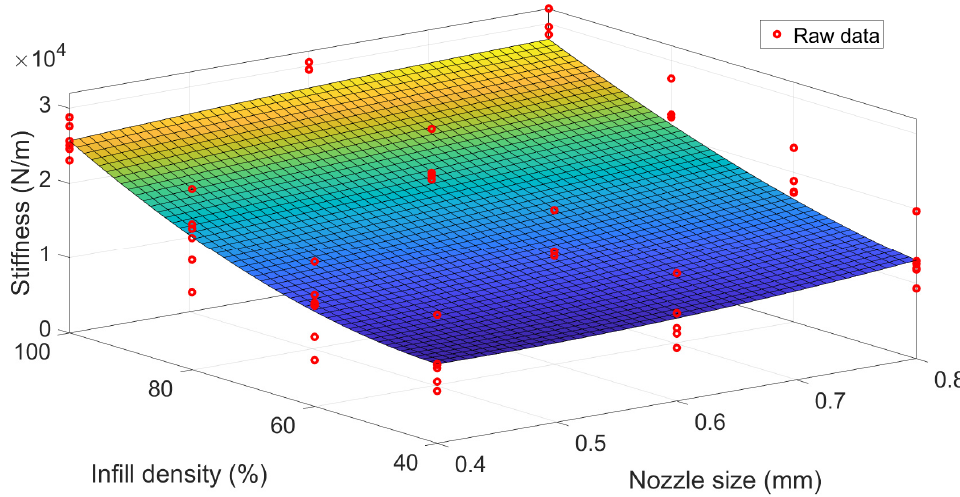
Figure 9. A nonlinear correlation between process parameter and stiffness.